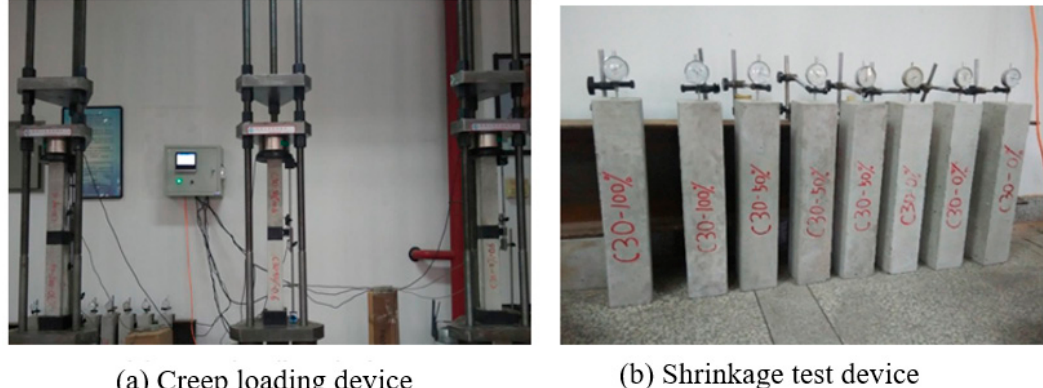
Figure 1. Site loading schematic.